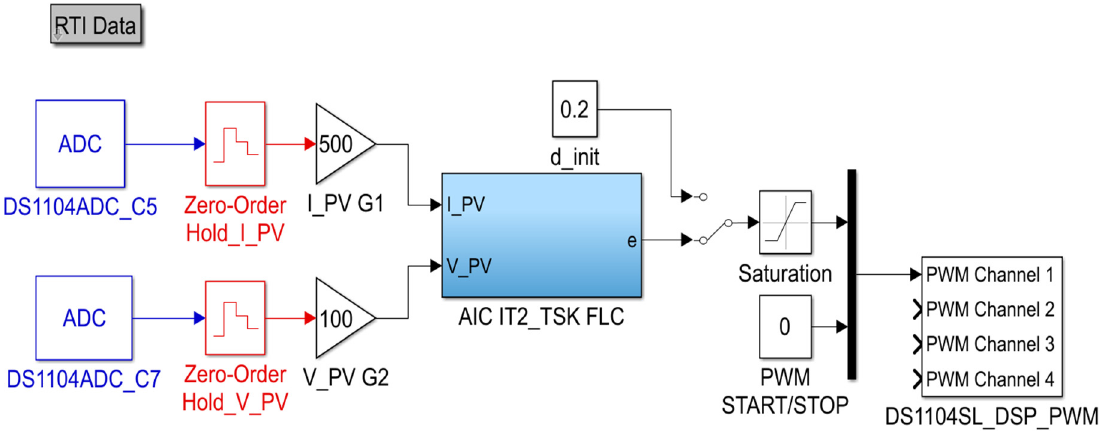
Figure 14. RTI model for proposed hybrid control structure.